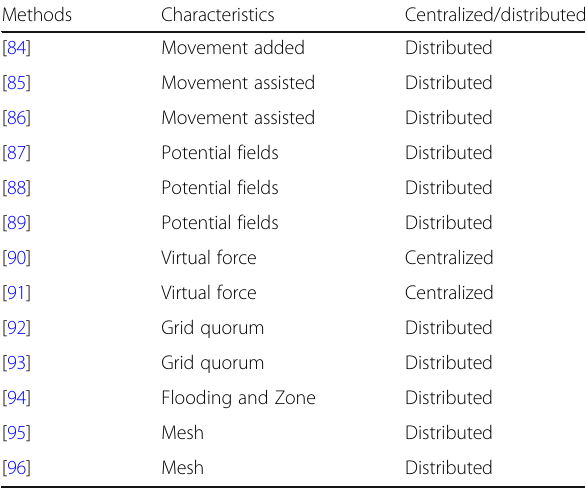
Table 9 Various methods compare centralized/distribution approaches